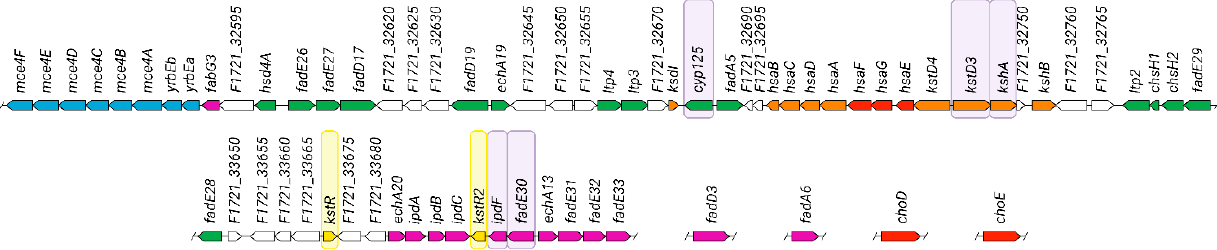
Figure 5. Organization of the S. hirsuta sterol catabolism gene cluster. Genes putatively involved in cholesterol catabolism are in green; genes related to the A/B-ring degradation are in red and orange; genes coding for C/D-ring degradation are in purple; genes coding for transport systems are in blue; and regulatory elements are in yellow. Five genes of interest are marked with light violet frames. The two transcriptional repressor genes kstR and kstR2 are marked with yellow frames (adopted from [15]).